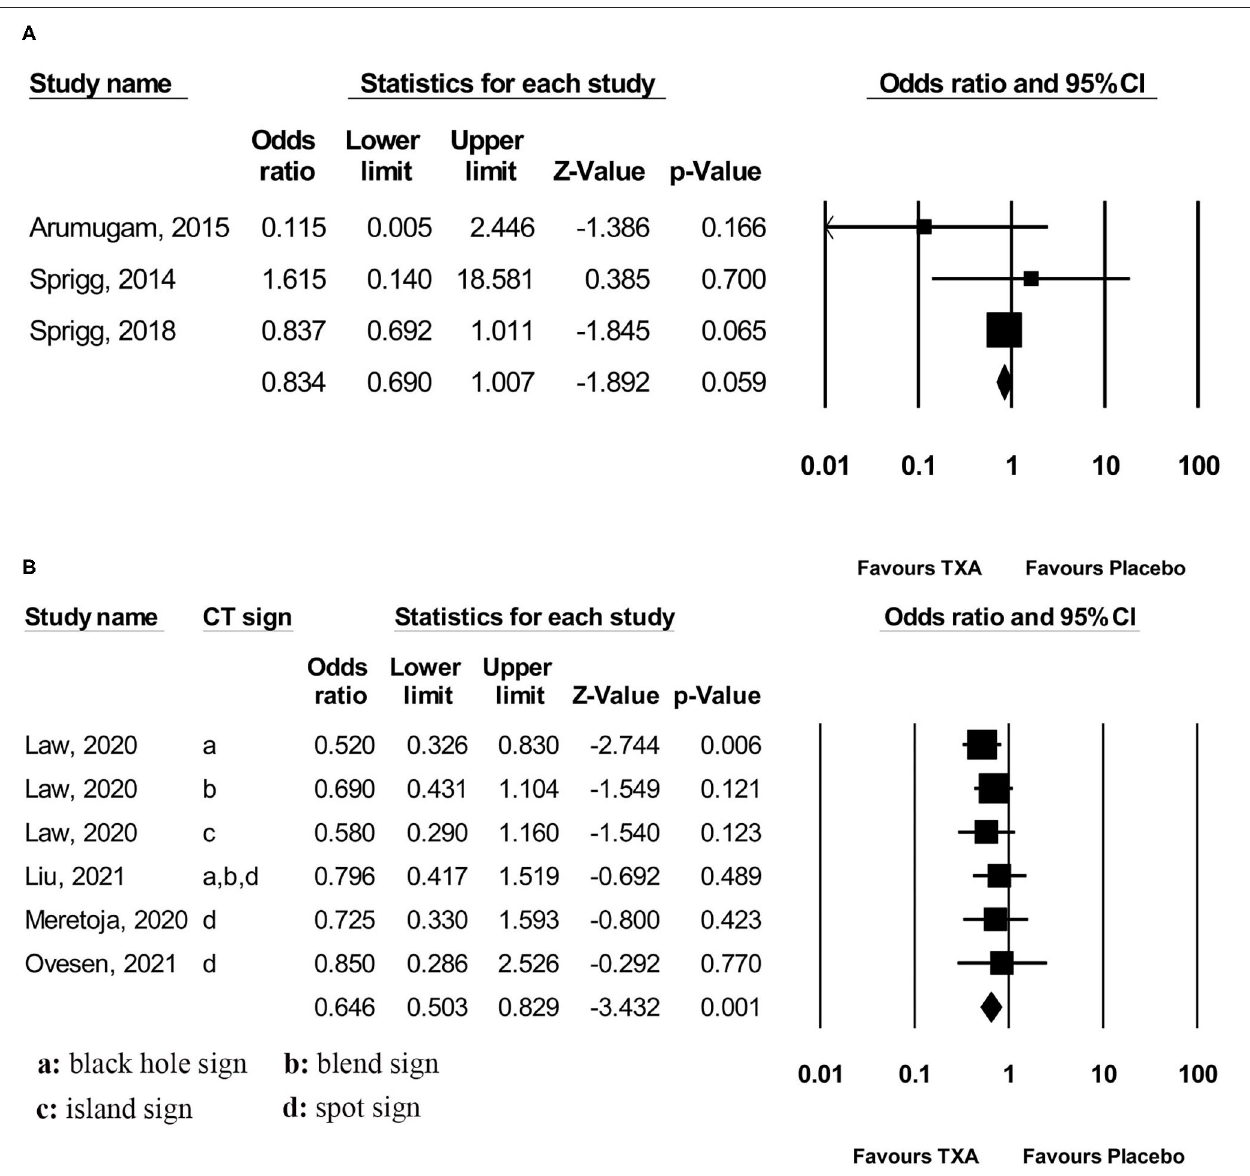
FIGURE 4 | Subgroup analysis of primary outcome measurement: (A) standard-risk population and (B) high-risk population. TXA, tranexamic